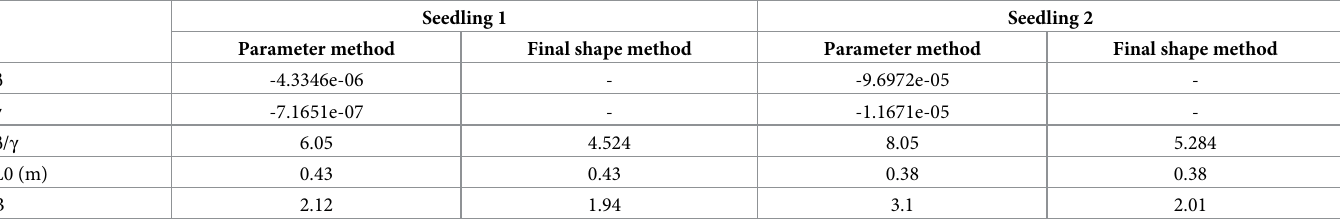
Table 2. Values of gravitropic ( β ) and proprioceptive ( γ ) sensitivities (SI unit) and B determined with AC model phenotyping with the “parameter model method” and the “final shape method”, on the whole